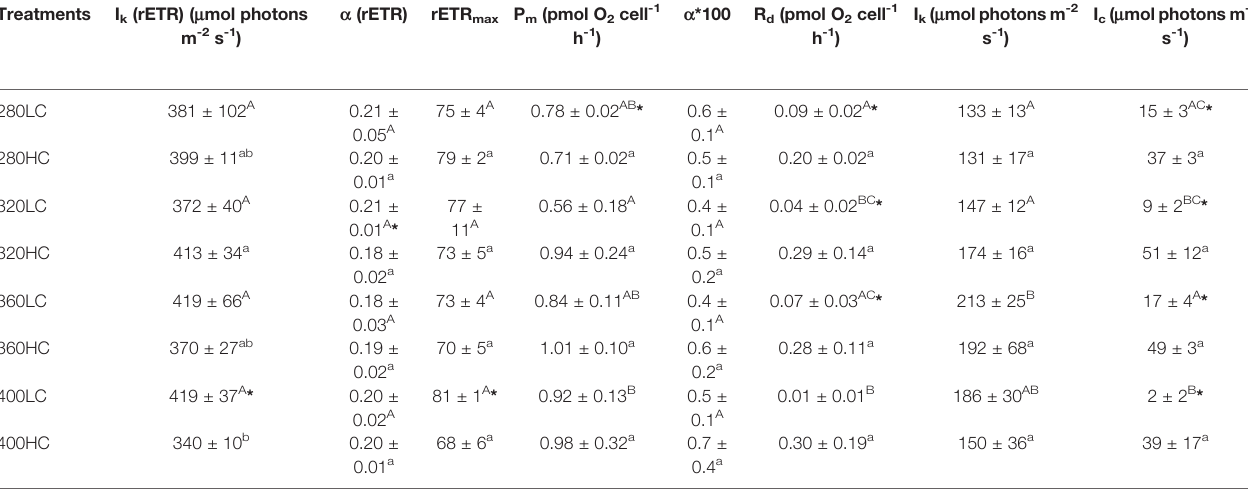
TABLE 1 | Photosynthetic parameters of P-I and rapid light curves for S. costatum acclimated to ambient and elevated CO 2 in different spectral treatments. Treatments I k (rETR) ( m mol photons m -2 s -1 )